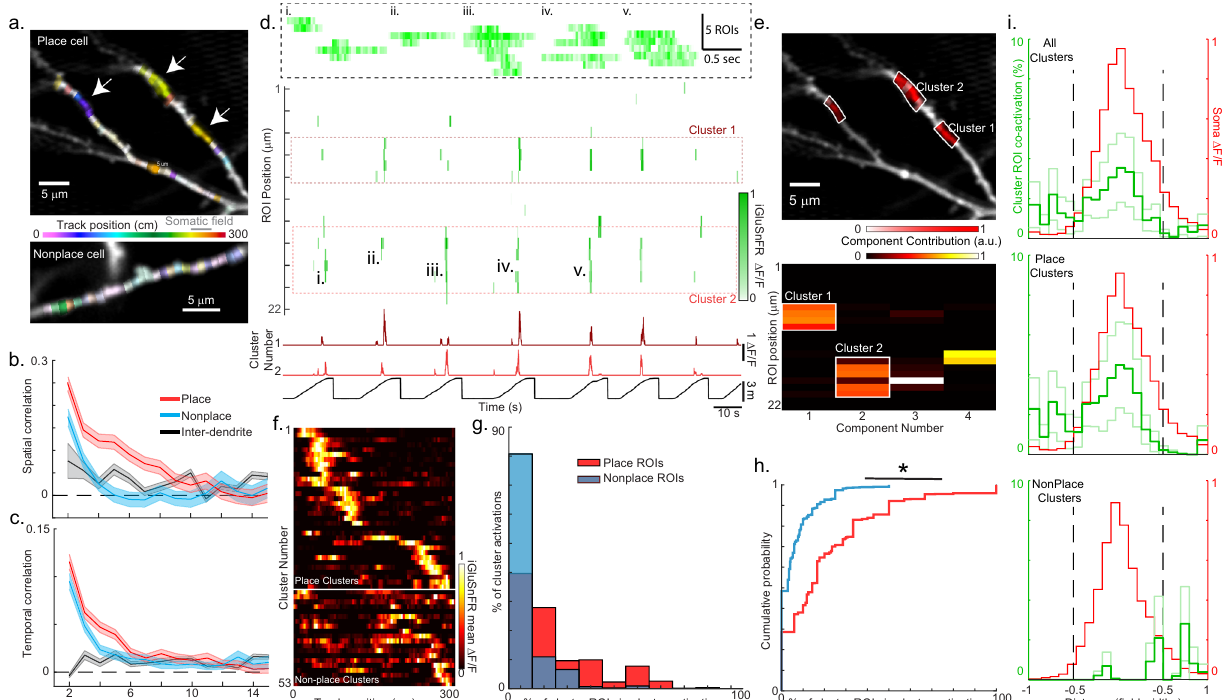
Fig. 4 Excitatory inputs are more temporally co-active and anatomically clustered in the somatic place fi eld versus out. a Dendritic segments from a place cell (top) and nonplace cell (bottom) with ROIs colored according to the center of mass of each ROI ’ s mean Δ F/F map. The brightness indicates peak Δ F/F value in the mean Δ F/F map divided by the spatial dispersion. Track location of somatic place fi eld for place cell (top) shown in gray. Similar results were obtained from 23 place cells and 23 nonplace cells from 11 mice. b Spatial correlation (Pearson ’ s correlation) between the mean Δ F/F maps of all pairs of active ROIs on a single branch versus the dendritic distance between the pairs of ROIs, averaged over all branches from place (red) or nonplace (blue) cells. Inter-dendrite spatial correlation versus Euclidean distance for pairs of ROIs that belonged to different branches co-recorded in the same fi eld averaged over all pairs of branches from all dendritic iGluSnFR recordings (black). Shaded regions, SEM. c Temporal correlation versus dendritic distance plots calculated as in panel ( b ), except signi fi cant transient-only traces were used instead of mean Δ F/F maps. Shaded regions, SEM. d Matrix of signi fi cant iGluSnFR Δ F/F transient vs time traces (green, 100 ms bins) for 22 neighboring ROIs from the top branch shown in panel ( a , top) acquired during linear track navigation (track position at the bottom, black). ROIs for the 2 functional clusters from panel ( e , bottom) outlined in red dashed boxes and the associated cluster Δ F/F vs time traces shown in red (bottom). The expanded time base for fi ve events (i – v) shown in the black dashed box inset. Note that cluster activations (nonzero cluster Δ F/F) could occur as coactivation of all cluster ROIs, some of the cluster ROIs (often nonadjacent), or just one cluster ROI. e Bottom, non-negative independent components for the matrix shown in ( d ) (top), with 2 functional clusters highlighted in white. Top, Dendritic segments shown in ( a ), but ROIs belonging to 3 different functional clusters are highlighted in white. Similar results were obtained from 23 place cells and 23 nonplace cells from 11 mice. f Mean cluster iGluSnFR Δ F/F versus track position across all traversals of a single session for all functional clusters (each row represents single-cluster mean Δ F/F) from all place and nonplace cells. Plotted via cross-validation within each cluster category. g Histogram of percent of place (red) or active – nonplace (blue) ROIs that were part of a cluster that was co-active during a cluster activation (nonzero cluster Δ F/F). h Cumulative probability from histograms shown in panel ( g ). * p = 2.7e − 117, Rank-sum test, two-sided. i Mean cluster ROI coactivation (green, percentage of cluster activations with > 70% cluster ROI coactivation) as a function of distance from the center of the mean somatic place fi eld (red) for all clusters (top), all place clusters (middle), and all active – nonplace clusters (bottom). Mean (dark green) ± SE (light green). Source data are provided as a Source Data fi le for b , c , g , h , and i